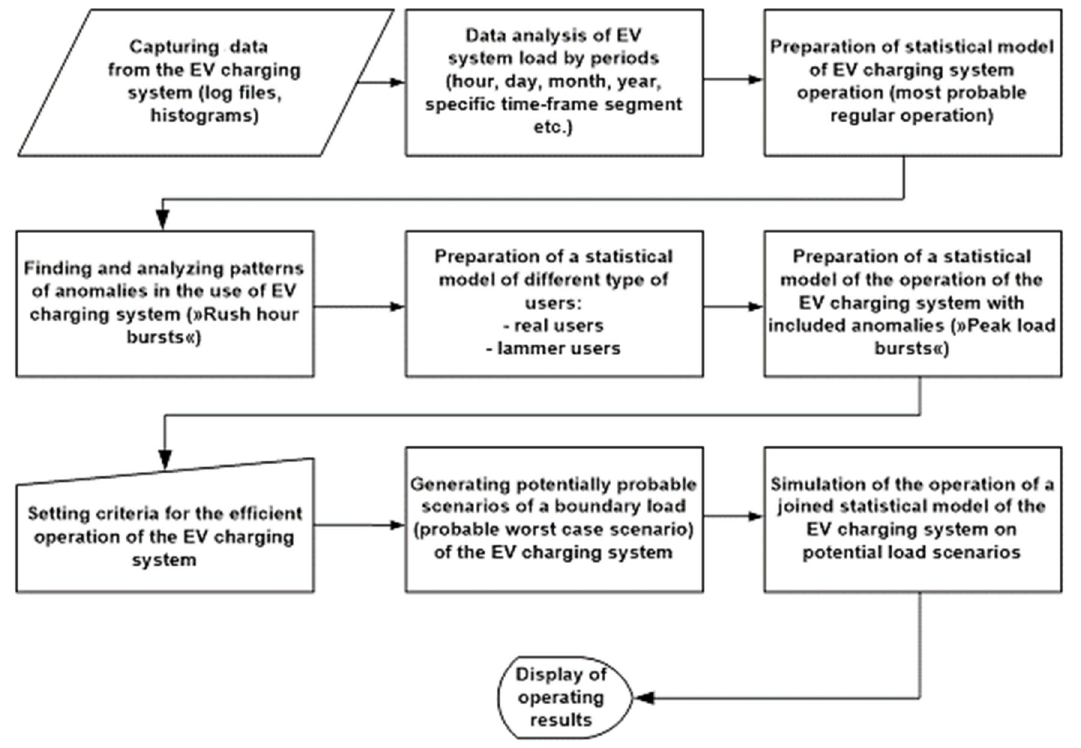
Figure 7. The flow chart of the proposed method.